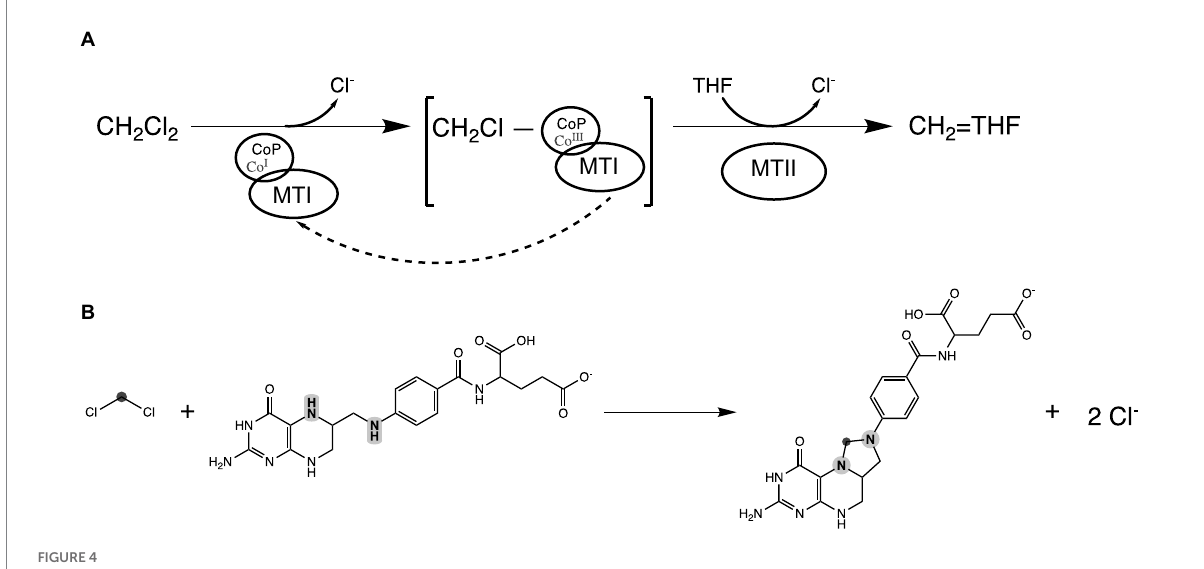
FIGURE 4 Proposed DCM dechlorination schema in strain DCMF. (A) Reduced Co(I) corrinoid protein (CoP), acting in concert with a methyltransferase I protein (MTI), cleaves the first chlorine from DCM, producing a transient CH2Cl-CoP intermediate. Tetrahydrofolate (THF), bound to a methyltransferase II protein (MTII), then attacks the remaining carbon-chlorine bond, ultimately producing 5,10-methylene-tetrahydrofolate. The Co (III) in the corrinoid protein is reduced back to Co (I) by putative reductive activators of corrinoid-dependent enzymes (RACE) proteins, although this may not be required every reaction cycle. (B) The overall reaction showing DCM and THF producing 5,10-methylene-tetrahydrofolate. The carbon in DCM is highlighted in dark gray; the N5 and N10 nitrogen heteroatoms in tetrahydrofolate are highlighted in light